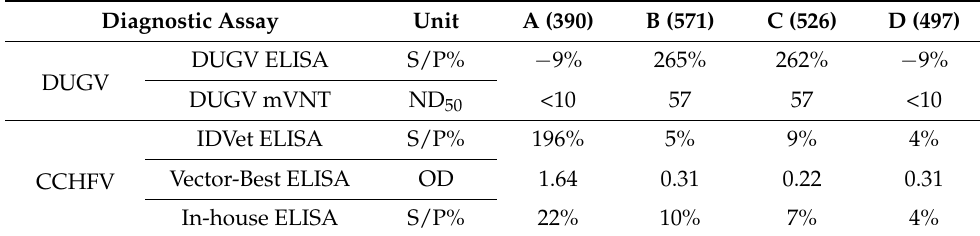
Table A2. Detailed version of Table 7 in the main